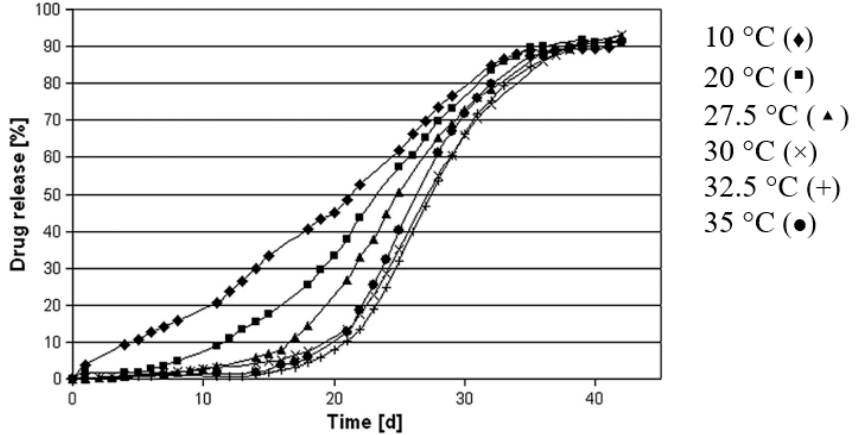
Figure 3. Drug release profiles of PLGA microspheres prepared under varying temperatures using emulsification solvent extraction/evaporation technique. High processing temperature results in a longer lag phase and a more pronounced sigmoidal drug release profile. (Reprinted from European Journal of Pharmaceutics and Biopharmaceutics , 81, Kerstin Vay, Wolfgang Frieß and Stefan Scheler, A detailed view of microparticle formation by in-process monitoring of the glass transition temperature, 399–408, Copyright (2012), with permission from Elsevier